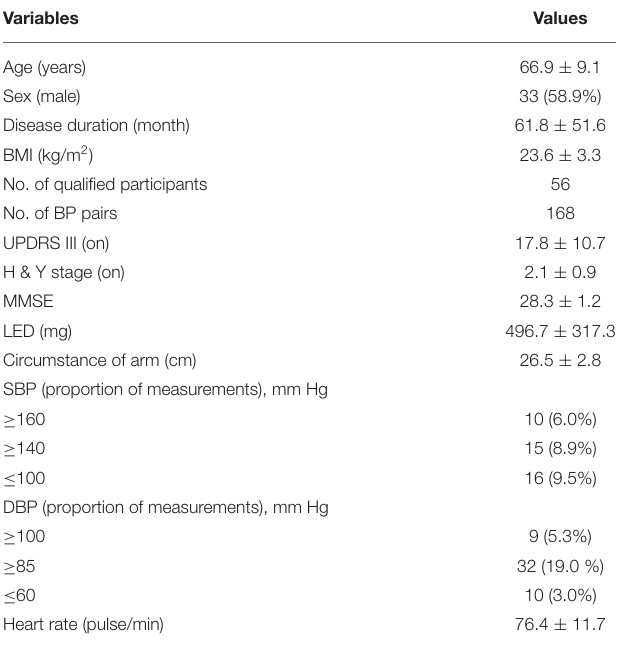
TABLE 1 | Clinical characteristics and demographics of the study population.